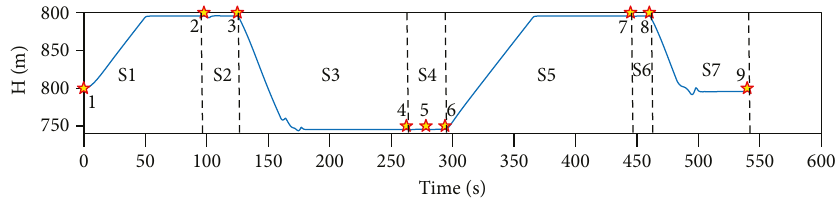
Figure 9: Comparison of the attitude angles.